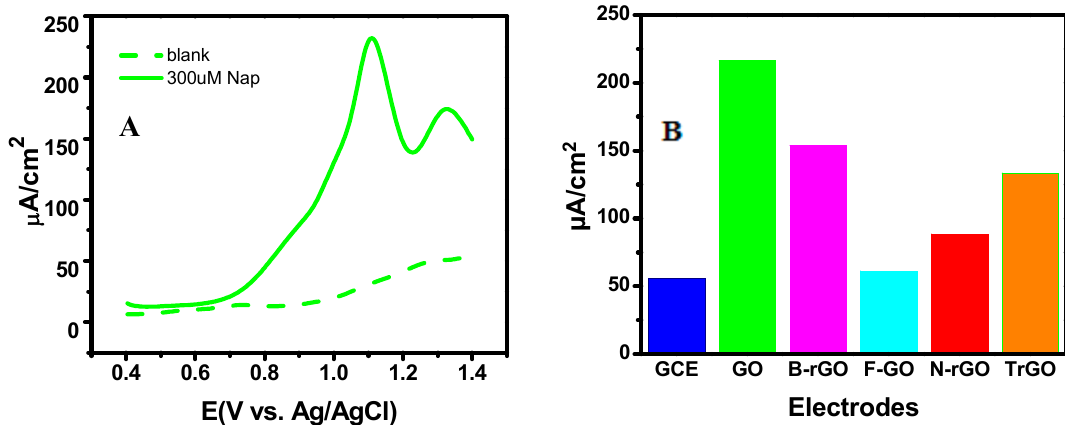
Figure 4. ( A ) Di ff erential pulse voltammetry (DPV) curve for the detection of naproxen at 300 µ M using GO / GCE. The dashed line is the blank measurement in the absence of naproxen. The solid line is the detection signal in the presence of 300 µ M naproxen. ( B ) Bar graph for the electrochemical performance of the examined electrodes.